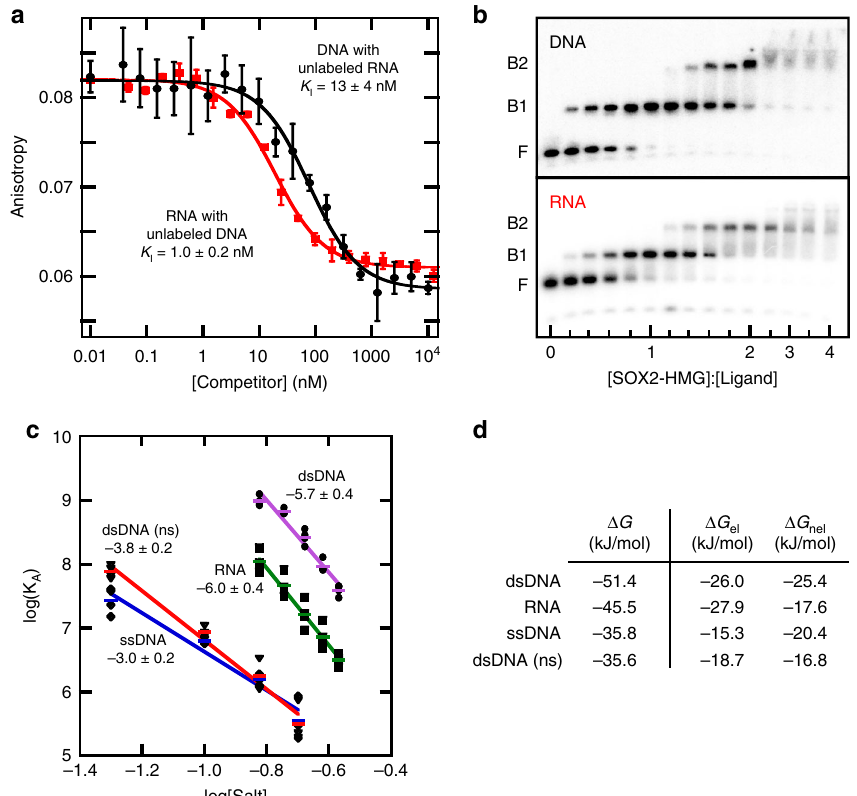
Fig. 4 Characterizing the nucleic acid-binding modes of Sox2-HMG. a Equilibrium competition binding assays measuring the anisotropy of the labeled nucleic acid as a function of unlabeled competitor. Binding curves presented as the average of n = 3 technical replicates with the error bars re fl ecting their s.d. b Determination of complex stoichiometry by EMSA. Migration of the radiolabeled nucleic acid species as a function of [Sox2-HMG]:[Ligand]. Bands are denoted as F (free), B1 (bound species 1), and B2 (bound species 2). Quanti fi cation provided in Supplementary Fig. 5. c Analysis of the salt dependence of the Sox2-HMG/nucleic acid interactions. The colored bars show the measured binding af fi nities as the average of the n = 4 with the standard error reported (black shapes). The calculated slope of each linear regression is provided. d The calculated values of the electrostatic ( Δ G el ) and non-electrostatic ( Δ G nel ) components to binding the indicated nucleic acid ligand under the standard reaction